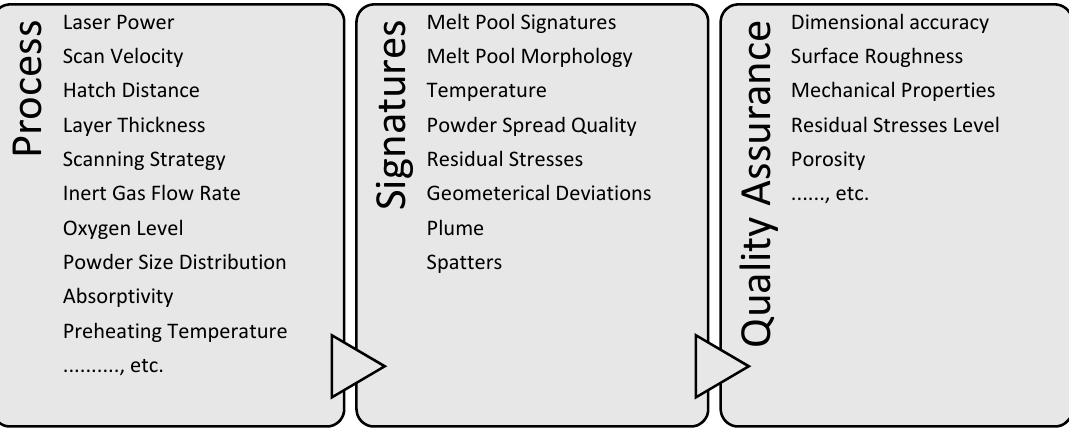
Figure 1. List of process parameters, and corresponding signatures which influence the product quality [2].